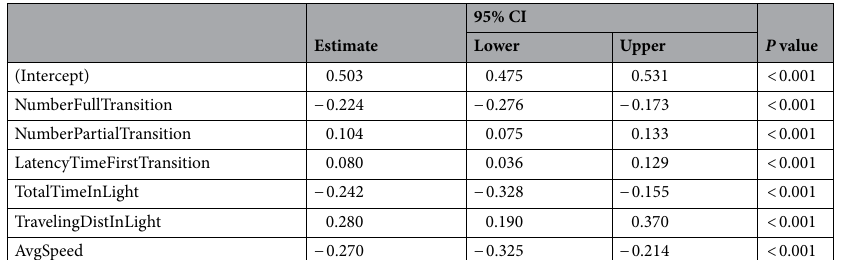
Table 1. Anxiety regression model. Estimated coefficients of anxiety-related phenotypes in our anxiety risking scoring model constructed from 445 mice from 30 CC strains, where Intercept is the expected mean anxiety risk score when all anxiety-related phenotypes measured 0. CI confidence interval, NumberFullTransition number of full transitions, NumberPartialTransition number of partial transitions, LatencyTimeFirstTransition latency time to enter the dark box for the first time, TotalTimeInLight total time in the light compartment, TravelingDistInLight traveling distance in light, AvgSpeed average speed in